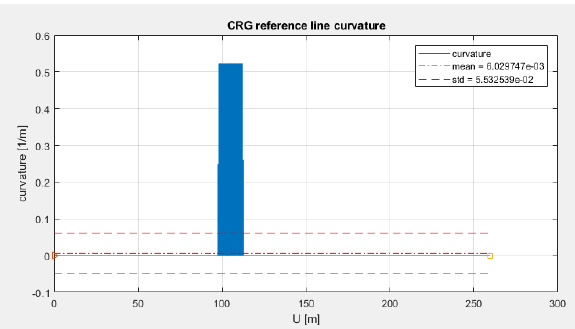
Figure 8. Curvature diagram for the MLS pilot site The computational time for the 5 cm MLS model was ~3 hours on a laptop with Intel Core i7 7700HQ processor and 16 GB RAM. This performance was achieved by the proof-of-concept run, but it can be significantly